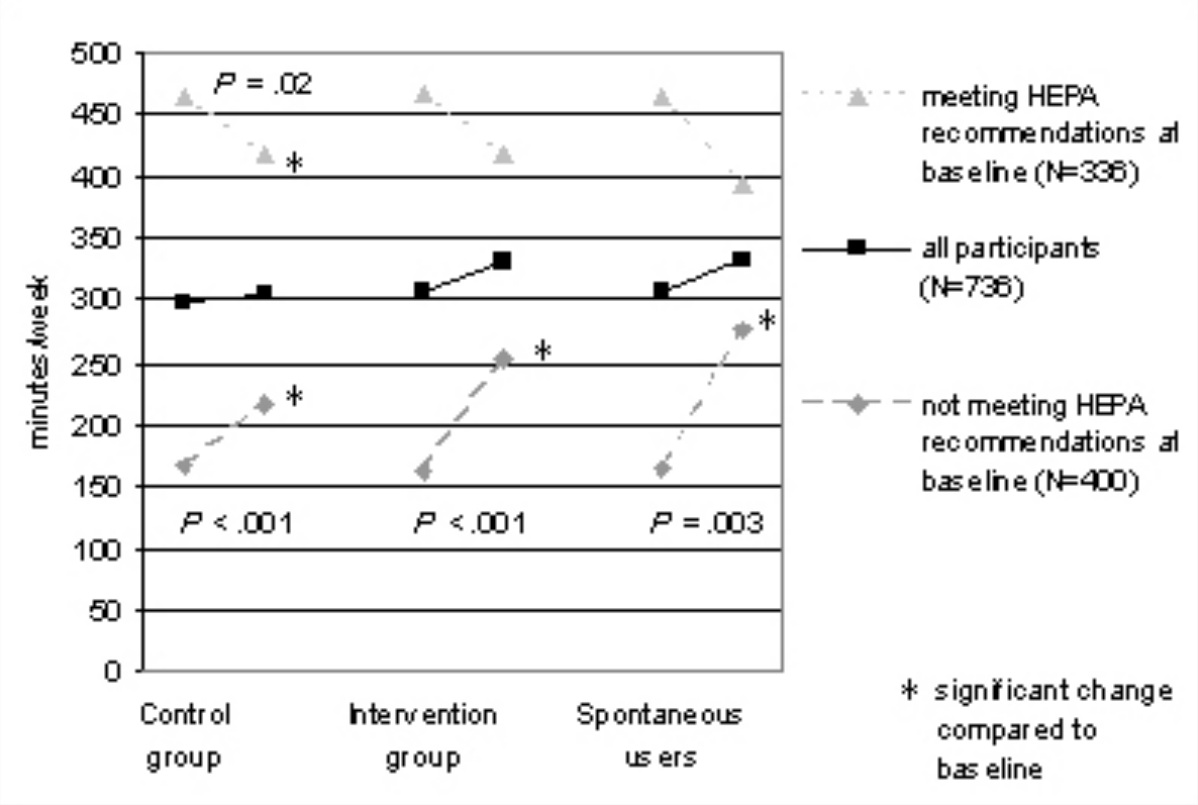
Table 2. Percent changes in self-reported physical activity between baseline and each follow-up according to group a